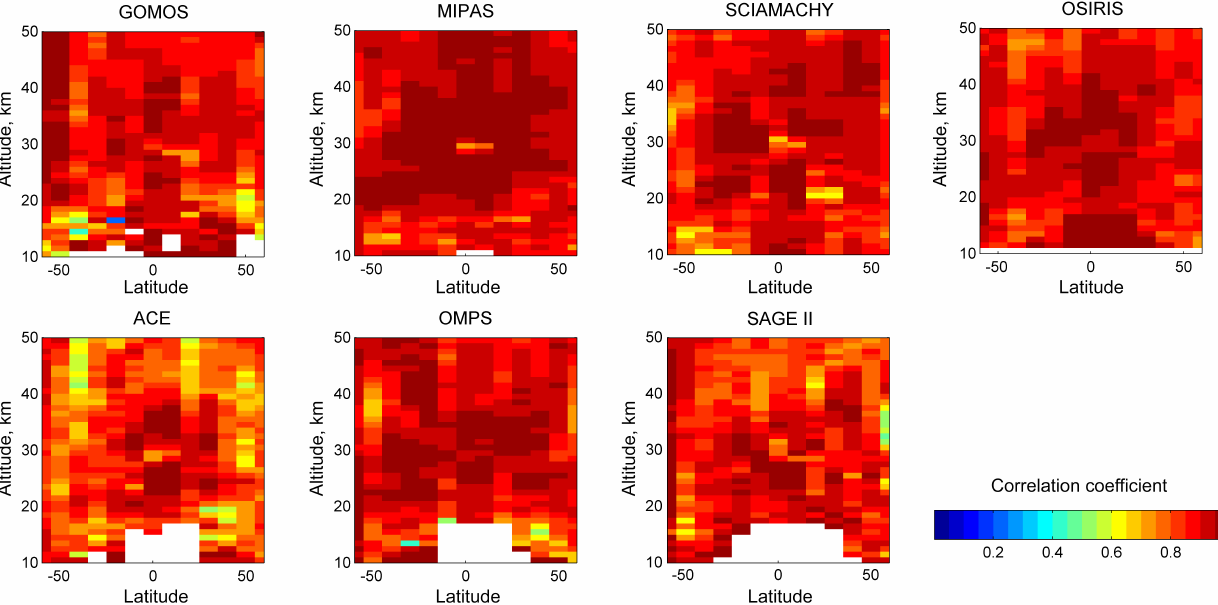
certainties σ , the uncertainty of the merged value will be √ σ/ 3. For the considered datasets, anomalies are usually very close to each other, so that several values are within the (cid:49) merged ± σ (cid:49), merged interval, as illustrated by Fig. S8 of the